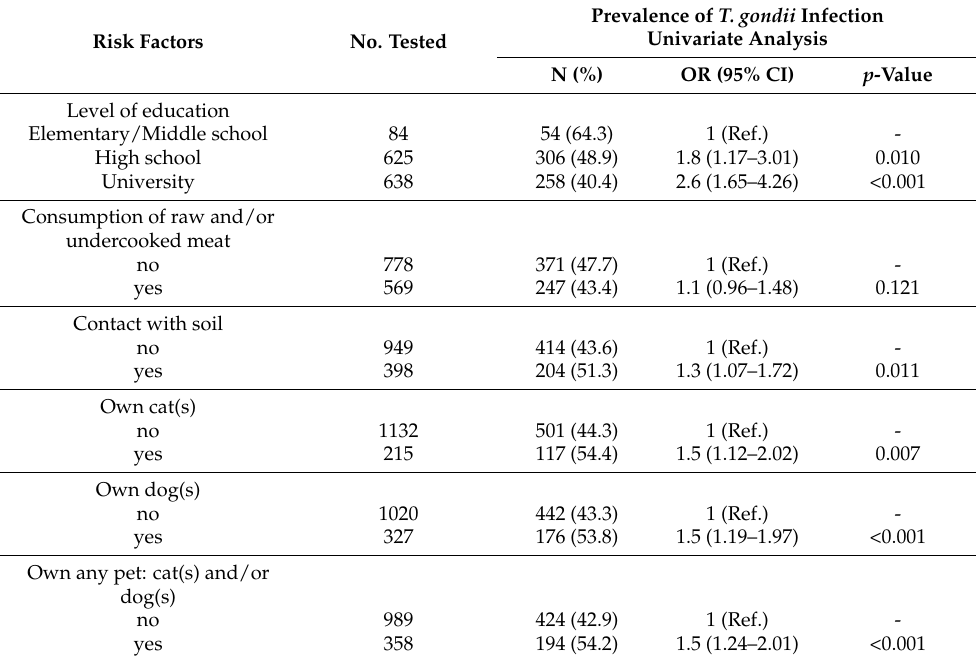
Table 3. Risk factors for Toxoplasma gondii infection in blood donors from Western Romania. Risk